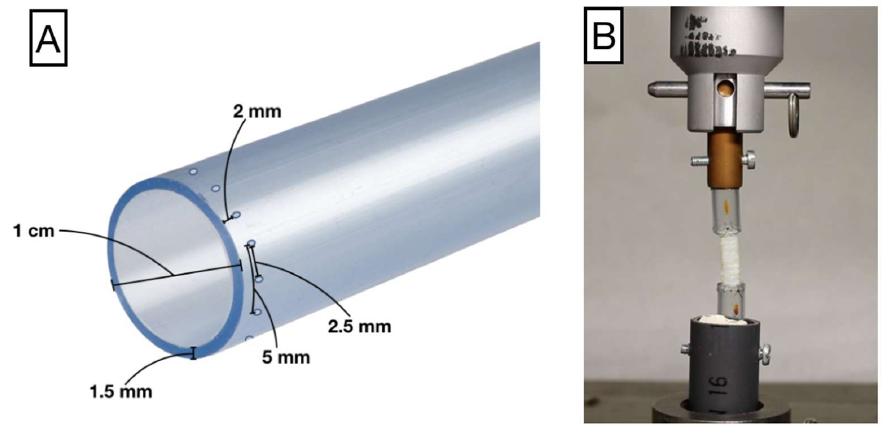
Figure 2. ( A ) Jaw model for trachea suture and stress analysis. ( B ) Trachea sutured to the jaw with a continuous suture. The jaws are attached to an adapter connected with the UTS.